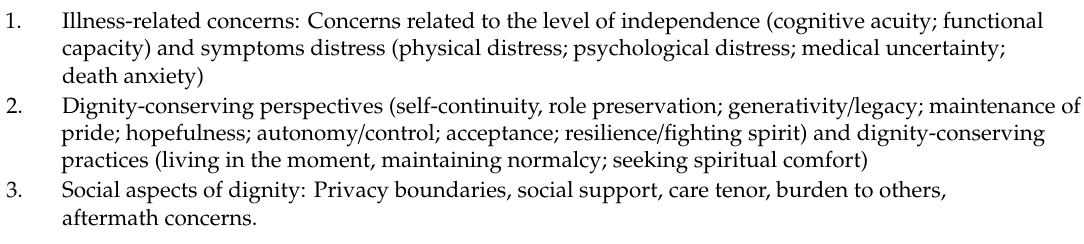
Table 1. Framework of dignity